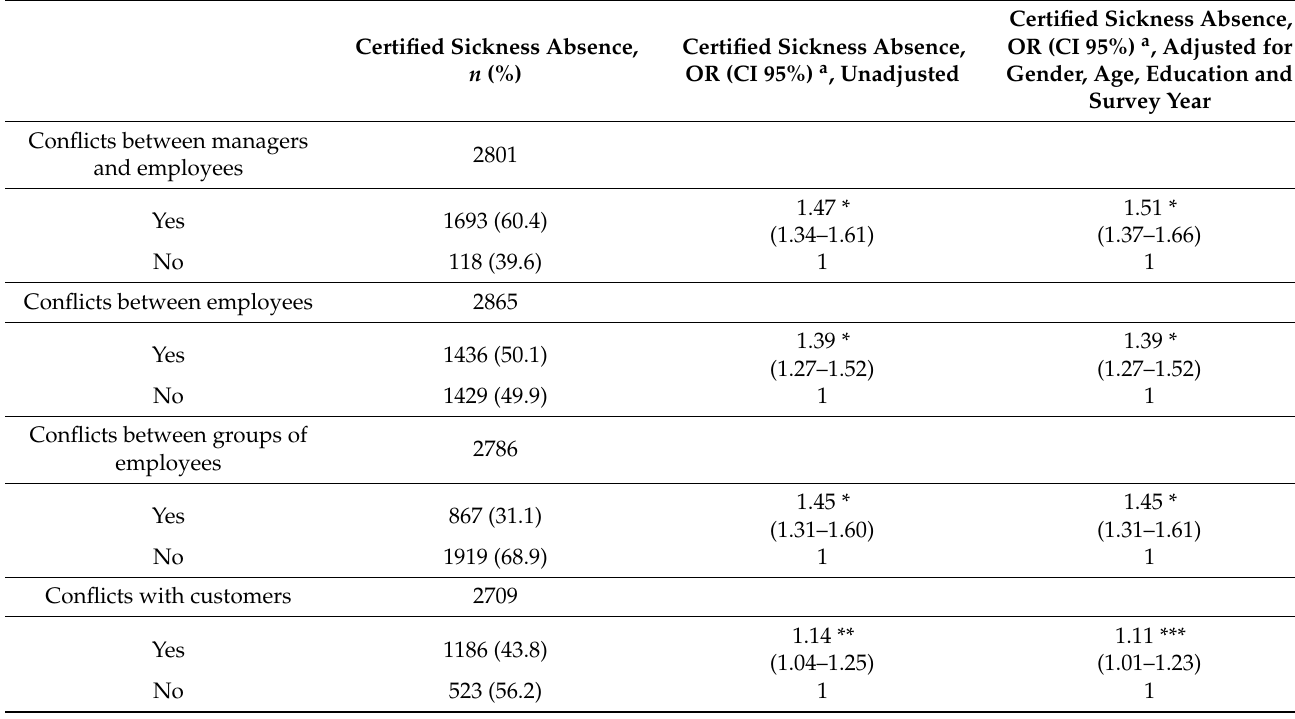
Table 4. The odds of self-reported medically certified sickness absence within the previous year in association with conflicts at